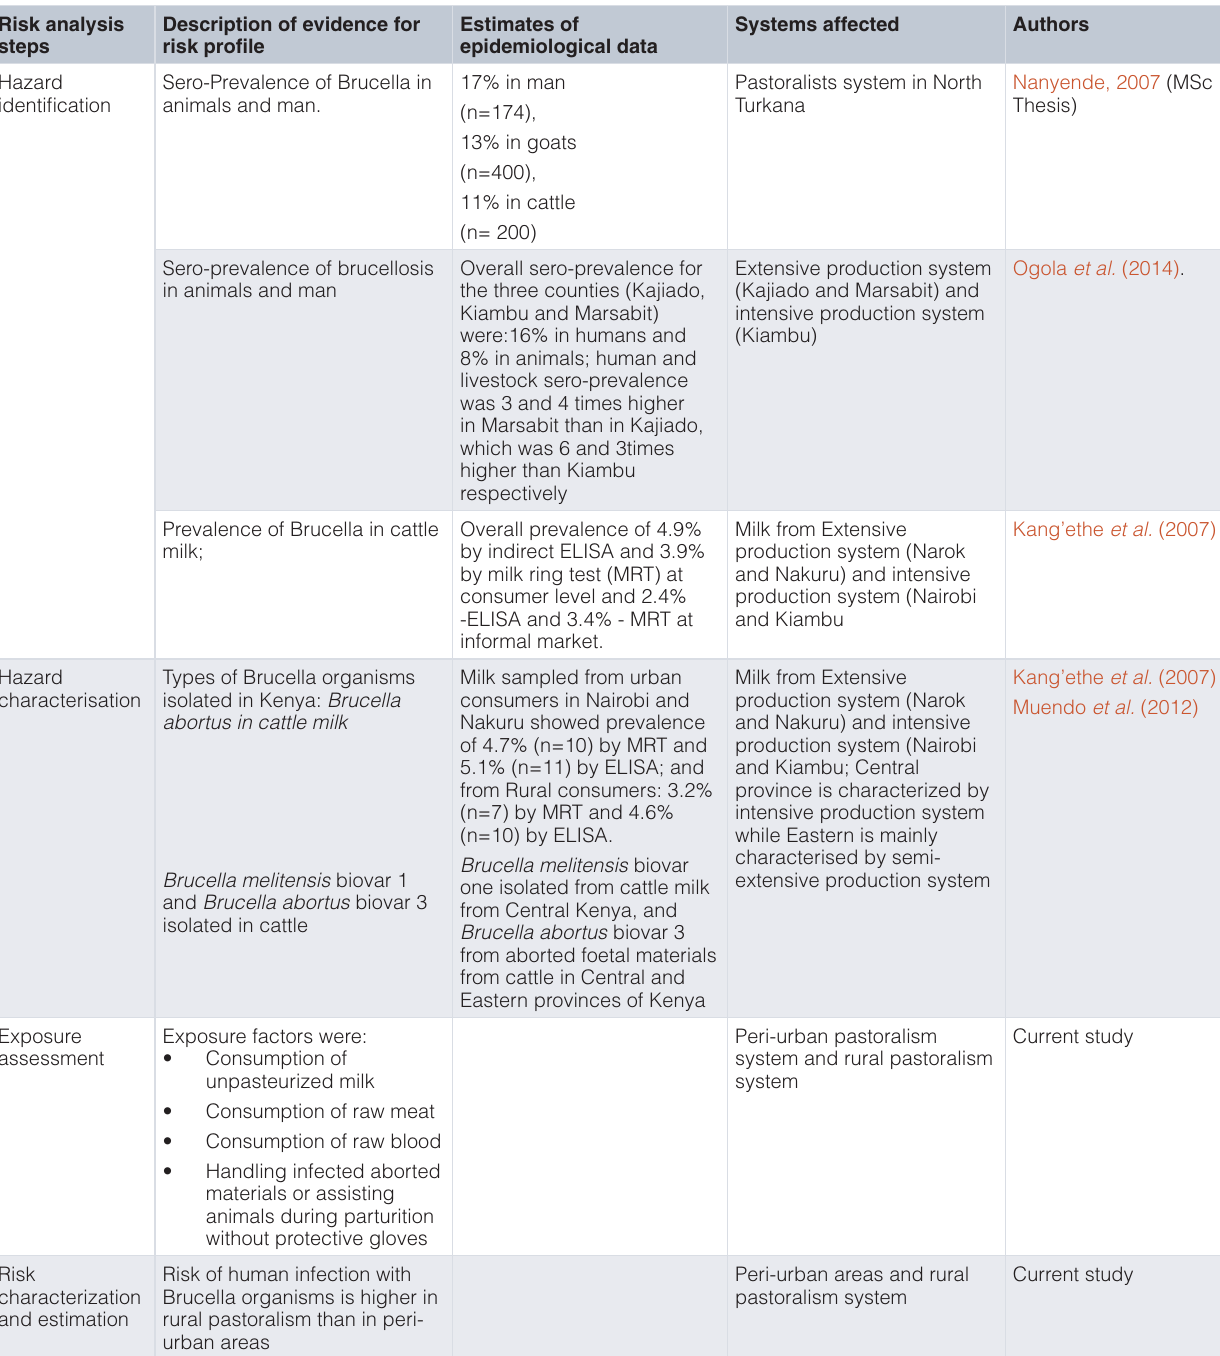
Table 2. Risk assessment for exposure to brucellosis in the pastoralist’s production system of Kajiado